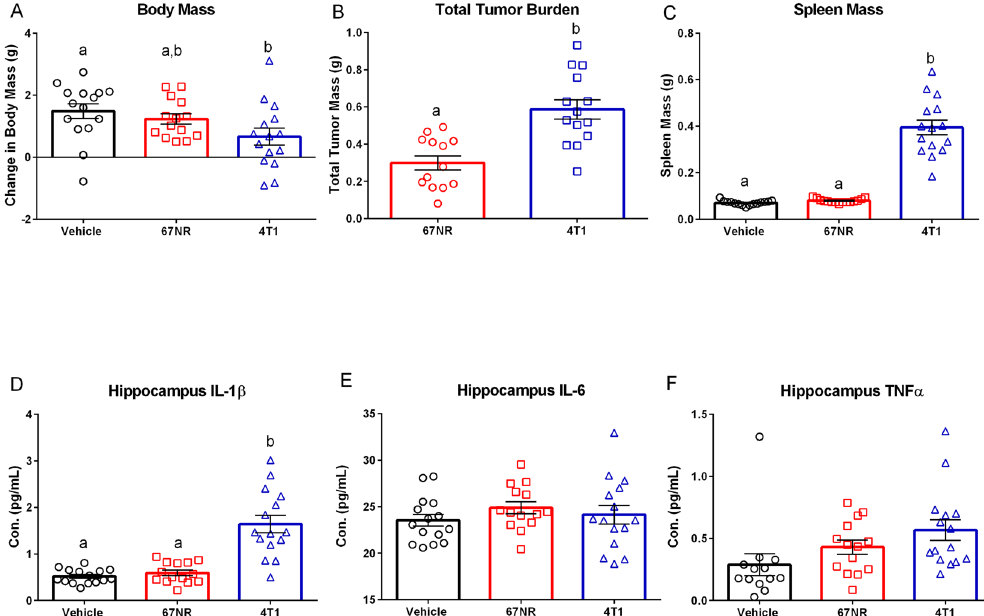
Figure 6. 4T1 Cells Generate both a Peripheral and Central Response. ( A ) Body mass difference between day of tumor inoculation (DOI) and day of euthanasia (DOE) accounting for tumor mass (TTB) for vehicle and each cell line ((DOE-DOI)-TTB). 4T1 tumors had reduced weight gain relative to vehicles. ( B ) Total tumor burden in grams; 4T1 tumors had significantly increased mass. ( C ) Spleen mass for vehicle and treatment groups. Spleen mass was significantly increased in 4T1 tumors relative to 67NR tumors and vehicles. ( D – F ) Hippocampus protein cytokine concentrations of IL-1 β , IL-6, and TNF α expressed in both vehicle and treatment groups. ( D ) Hippocampal IL-1 β was significantly increased in 4T1 tumors relative to 67NR tumors and vehicles. ( E ) There were no significant differences in hippocampal IL-6. ( F ) TNF α was increased in the hippocampus of 4T1 treated mice relative to vehicles. The measures and tissues were collected 20 days after tumor cell or vehicle inoculation (n = 12–15/group). The data are presented as mean + SEM. Graph bars that do not share a letter are statistically significant different at p <